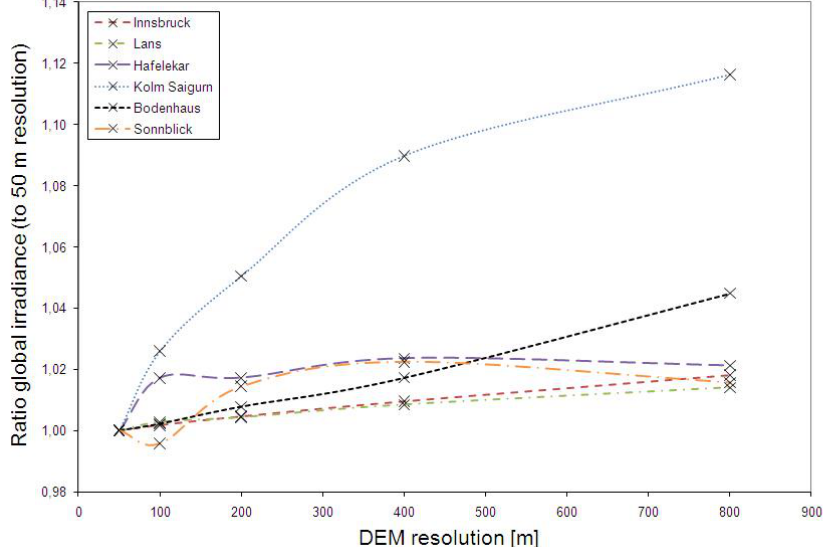
Fig. 3. Influence of changes in the horizon using different resolution DEMs on global irradiance. The change in global irradiance at 305nm is shown as a function of the respective DEM resolution (which has an effect of changing the modelled horizon at the various sites). The results are normalised to the results of the 50m DEM. Simulations were performed with a 1-D radiative transfer model by multiplying irradiance with the error factor due to sky coverage of the horizon (Appendix Eq. (11)). Solar zenith angle is 57 degree.